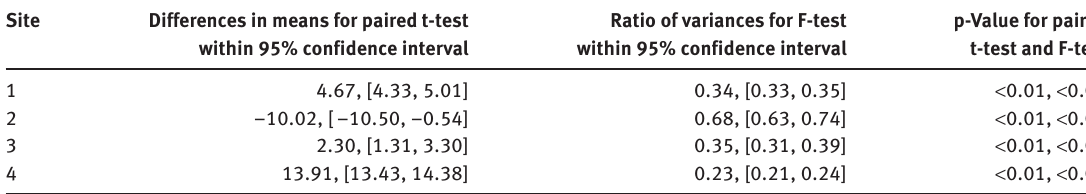
Table 5: Comparisons of Differences between Means and Variances Using Paired t-Test and F-test, p-Value with 95% Confidence Level at Different Sites for the Classes [Motorcycle (C1) and Long Trucks and Buses (C4)].